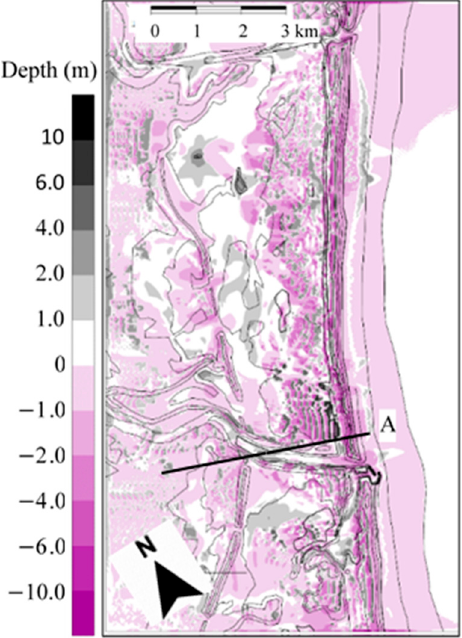
Figure 7. Topography change results (total bed-load), 48 min after tsunami calculations.